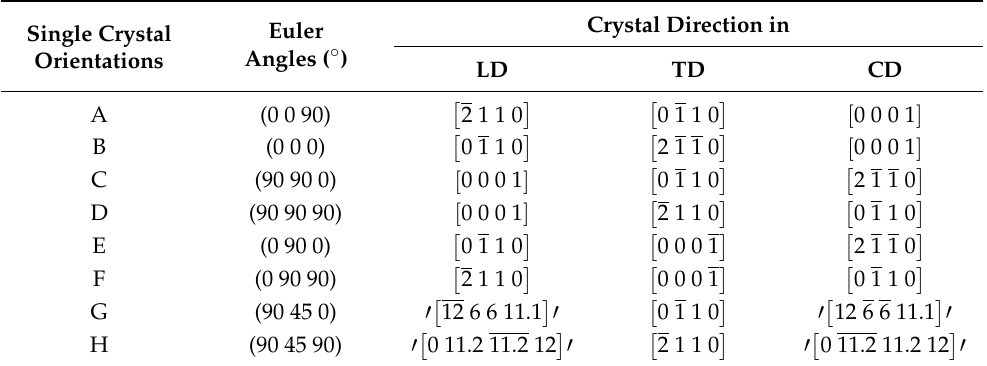
Table 1. Orientations of single crystal specimens deformed by plane strain compression in a channel- die. (Quotation marks indicate irrational directions with rounded indices). Euler angles are expressed as ( ϕ 1 , Φ , ϕ 2 ) in Euler space (in Bunge notation, with x || [0110 ] and y || [2110 ]). The deviation from the ideal orientations was less than 1 ◦